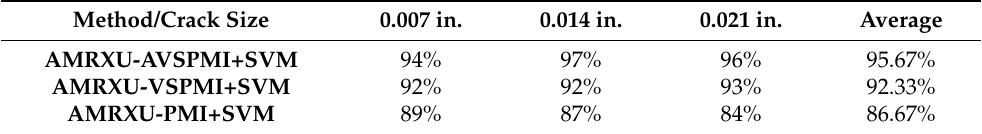
Table 11. The average accuracy for inner crack size detection using the proposed AMRXU-